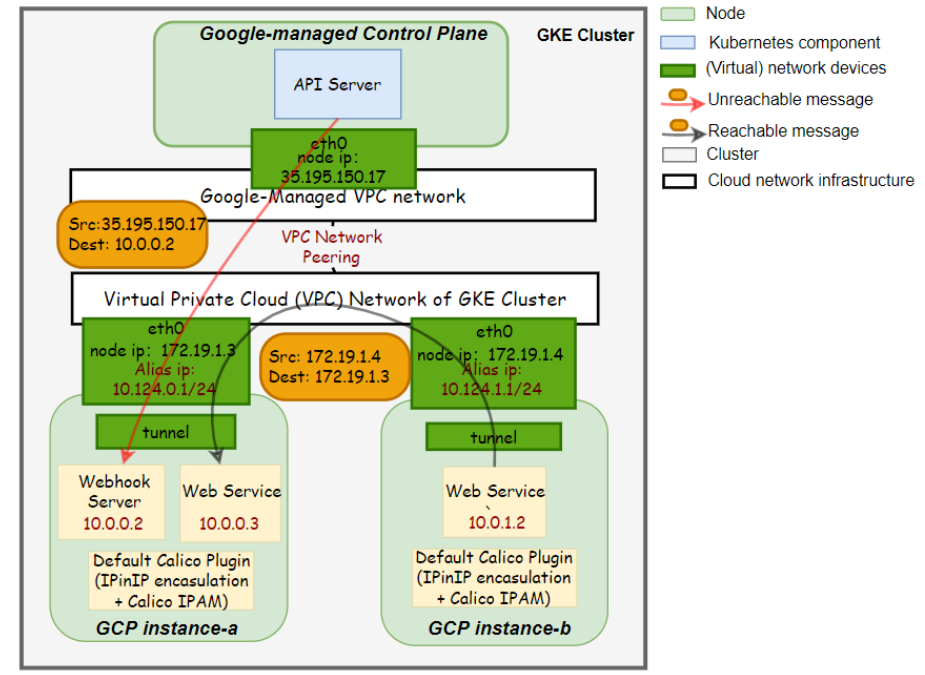
Figure 5. Pod connectivity in a GKE cluster with the default Calico plugin.